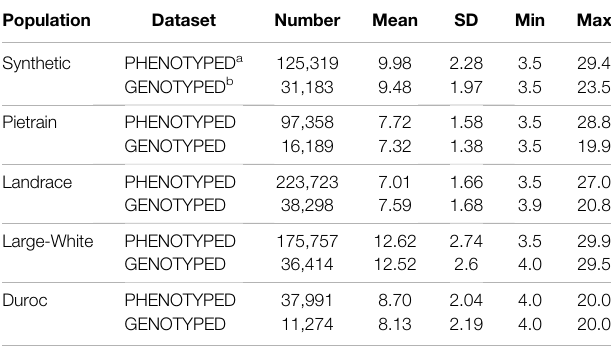
TABLE 1 | Summary statistics of the backfat (millimeters) per datasets and per evaluated population. Population